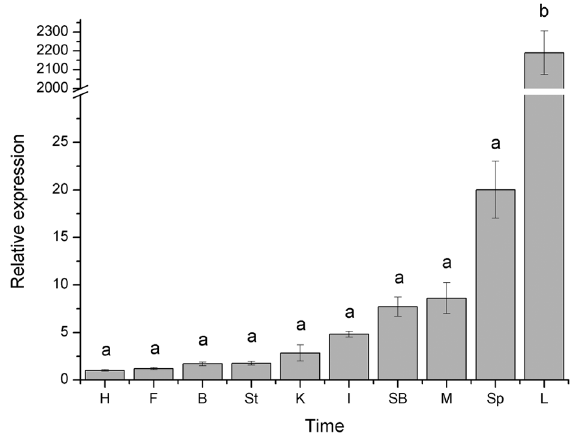
Figure 3. Expression of hepcidin gene in various tissues (heart (H), fin (F), brain (B), stomach (St), kidney (K), intestines (I), Swim bladder (SB), muscle (M), spleen (Sp), and liver (L) of uninfected miiuy croaker. Values with the same superscript are not significantly different ( P . 0.05).